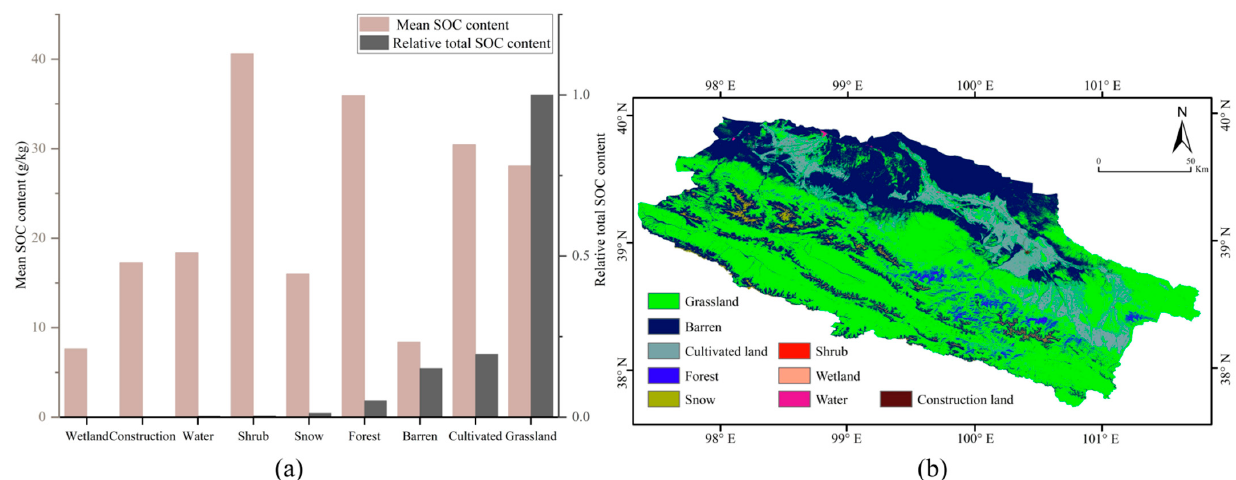
Figure 9. The mean SOC content and relative total SOC content of different land use types ( a ) and the spatial distribution of different land use types ( b ).